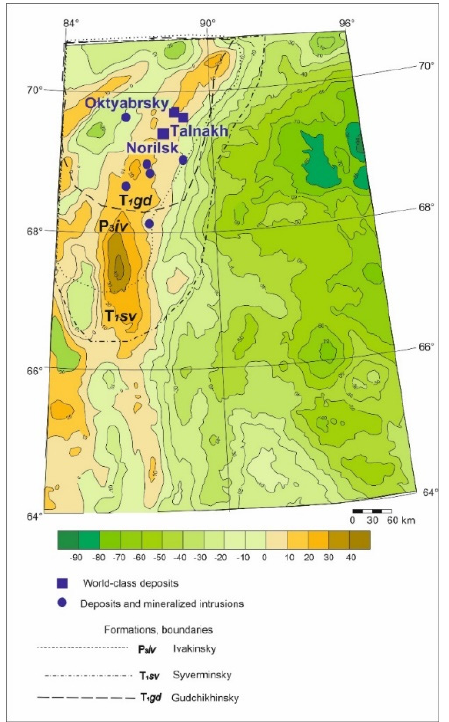
Figure 24. PGE-Cu-Ni deposits and boundaries of rift formations on the map of the isoanomals of the gravitational field (in conventional units) in the Buge reduction (c = 2.67 g/cm 3 ) at altitude 1.6 km for the NW Siberian platform